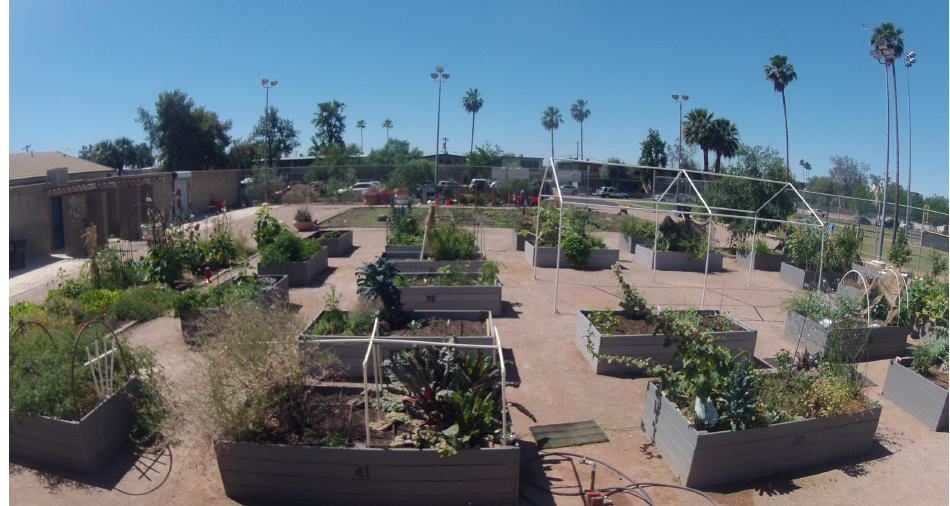
Figure 1. A bird’s eye view of the installation site.